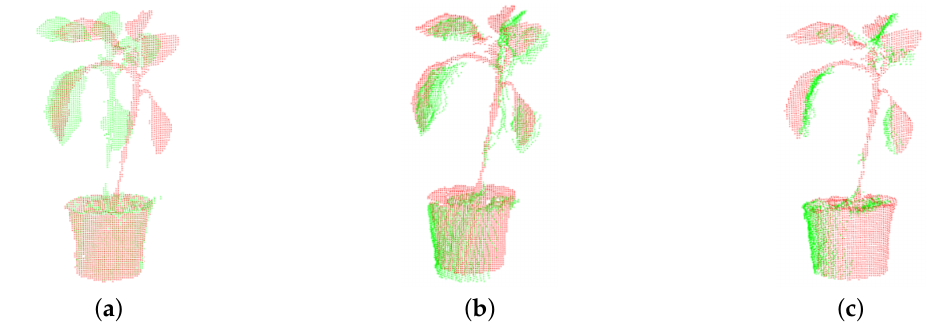
Figure 4. Comparison registering point cloud of angle 0 and angle 1 by traditional ICP algorithm with our algorithm. ( a ) Point cloud of angle 0 and angle 1 . ( b ) Registering point cloud of angle 0 and angle 1 by traditional algorithm. ( c ) Registering point cloud of angle 0 and angle 1 by our